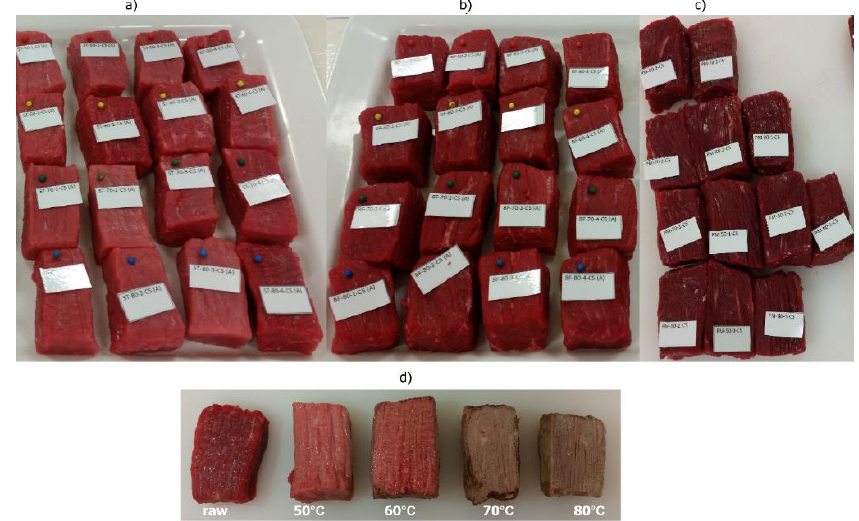
Figure 1. Cuboids from semitendinosus ( a ), biceps femoris ( b ) and psoas major ( c ) cut to 50 mm × 30 mm × 30 mm before cooking. ( d ) Centre of the cuboids from biceps femoris , raw and cooked to 50 °C, 60 °C, 70 °C and 80 °C for 30 min (Tc + 30 min.).